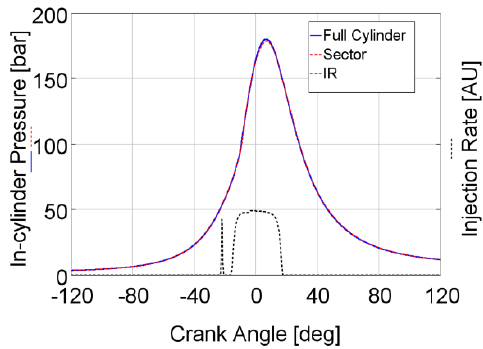
Figure 6. In-cylinder pressure comparison between full-cylinder geometry (solid blue) and sector mesh approach (dashed red), injection rate (dashed black). WP: 4000 rpm, 18.5 bar BMEP.